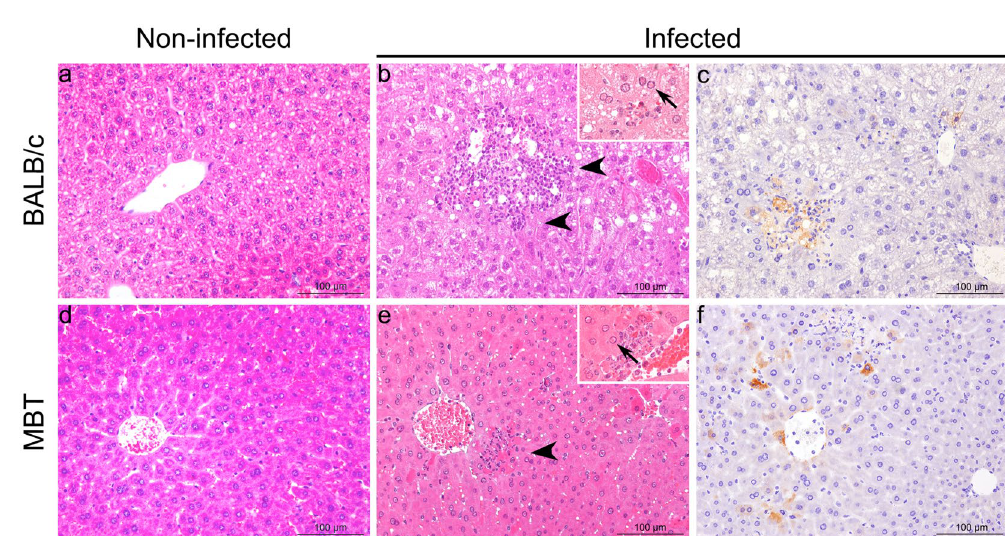
Figure 2. Histopathological analysis from non-infected and RVFV-infected BALB/c and MBT mice at day 3 post infection. ( a , b , d , e ) Hematoxylin and eosin (HE) staining of liver: arrowheads indicate lesions with necrotic and apoptotic hepatocytes, and neutrophil infiltrate (insets: intra-nuclear inclusion bodies with margination of nuclear chromatin, arrows). ( c , f ) Immunohistochemical detection of the N protein of